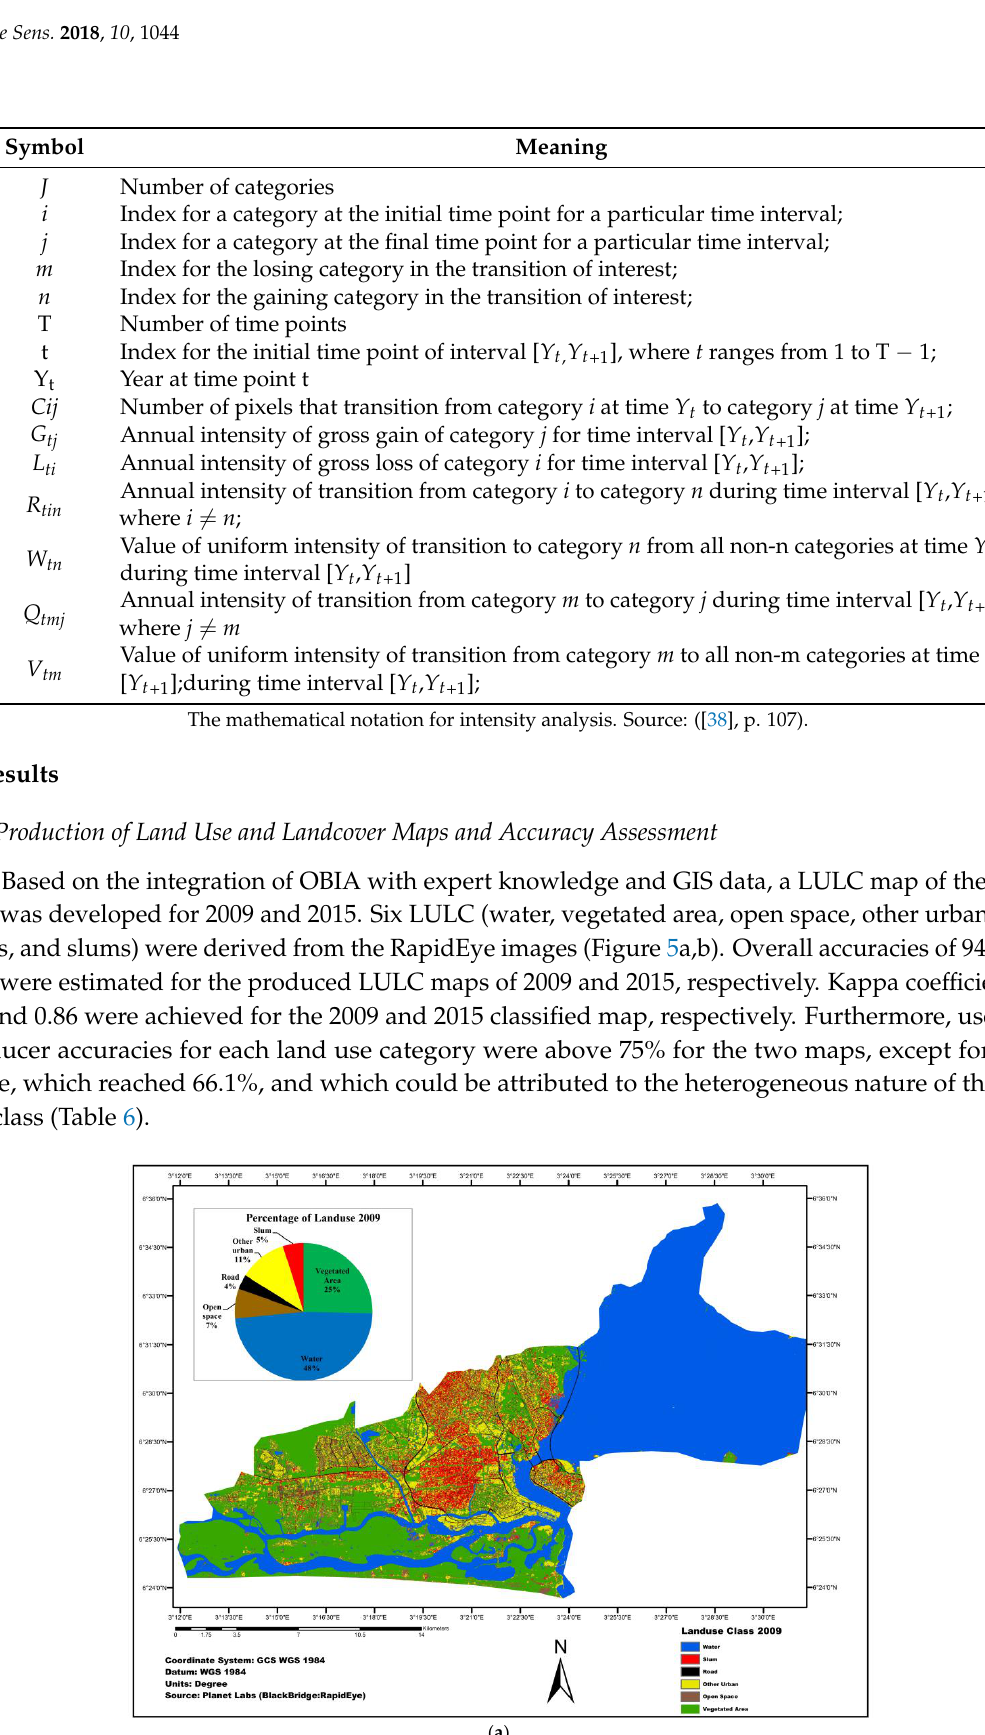
( b ) Figure 5. ( a ) Land use/cover map of study area in 2009; and ( b ) land use/cover map of the study area in 2015.